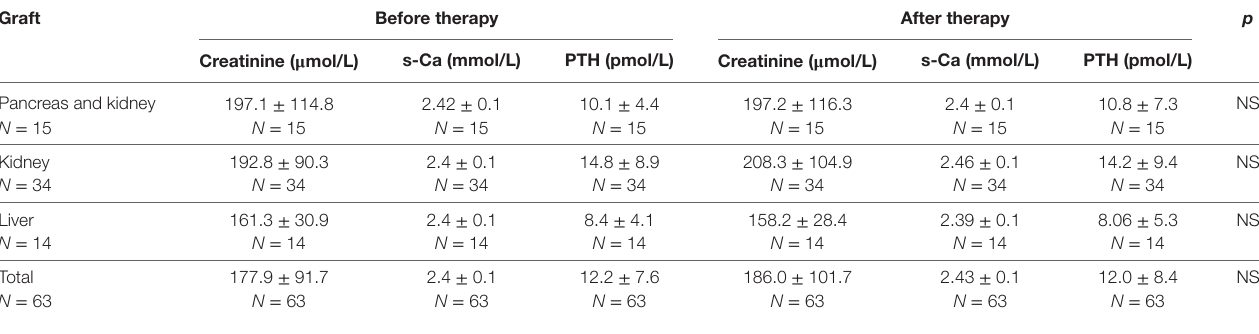
Table 1 | Biochemical profile before and after denosumab therapy (mean ± SD). graft before